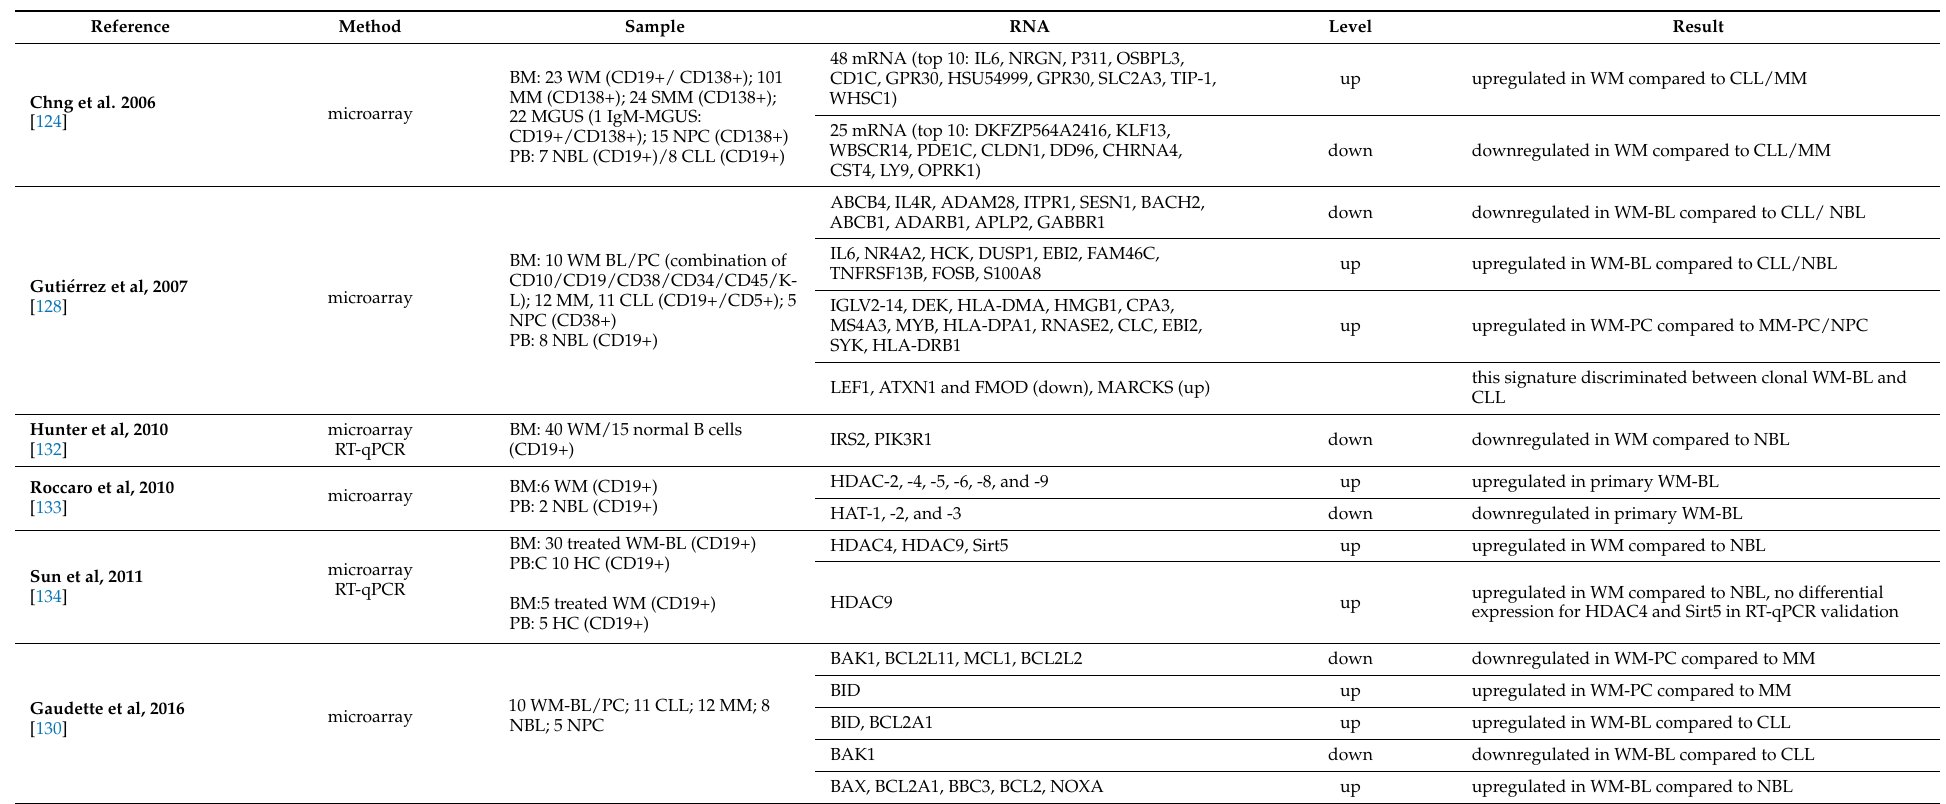
Table 4. mRNA expression in WM. DE: differentially expressed; HC: healthy control; MM: multiple myeloma; MM-PC: MM’s plasma cell; PB: peripheral blood; RT-qPCR: reverse transcription-quantitative PCR; WM: Waldenström macroglobulinemia; WM-BL: Waldenström’s B lymphocyte; WM-PC: Waldenström’s plasma